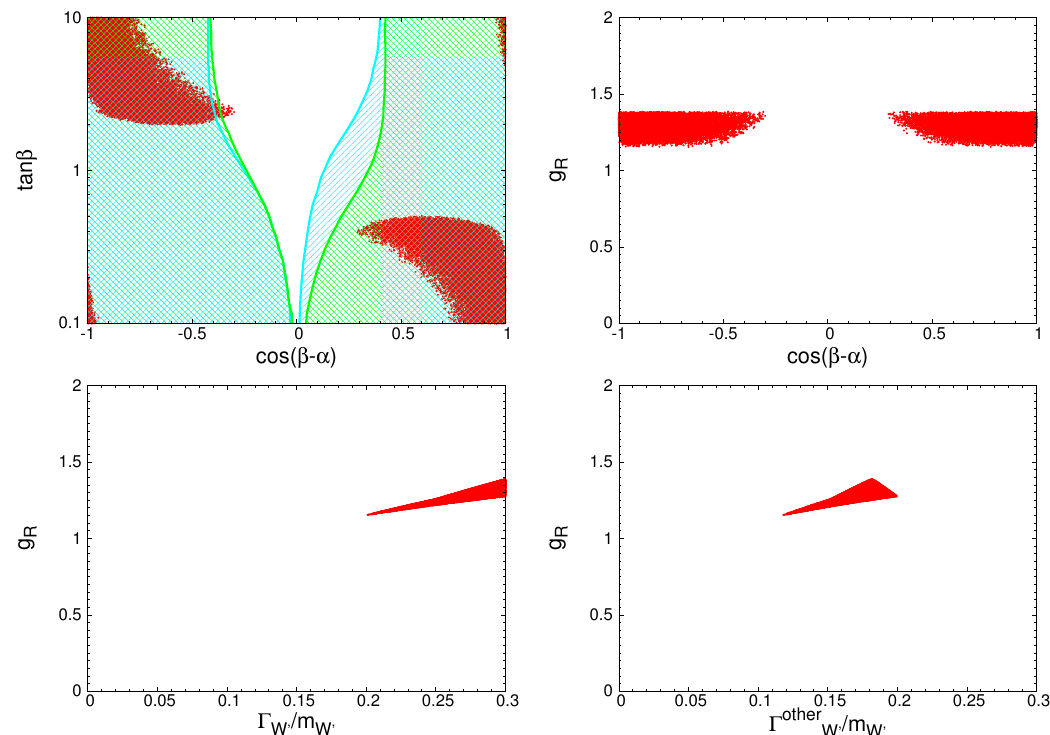
Figure 1 . The red-dotted points for m W 0 = 3 TeV satisfy the signal production cross section (cid:27) ( pp ! W 0 ! WH ) (cid:21) 4 : 5 fb, the upper limits listed in table 2, and the dijet upper limit adapted for the broad-width resonance. The cyan (green) hatched region was excluded by the Higgs precision data of Type-I 2HDM [18,